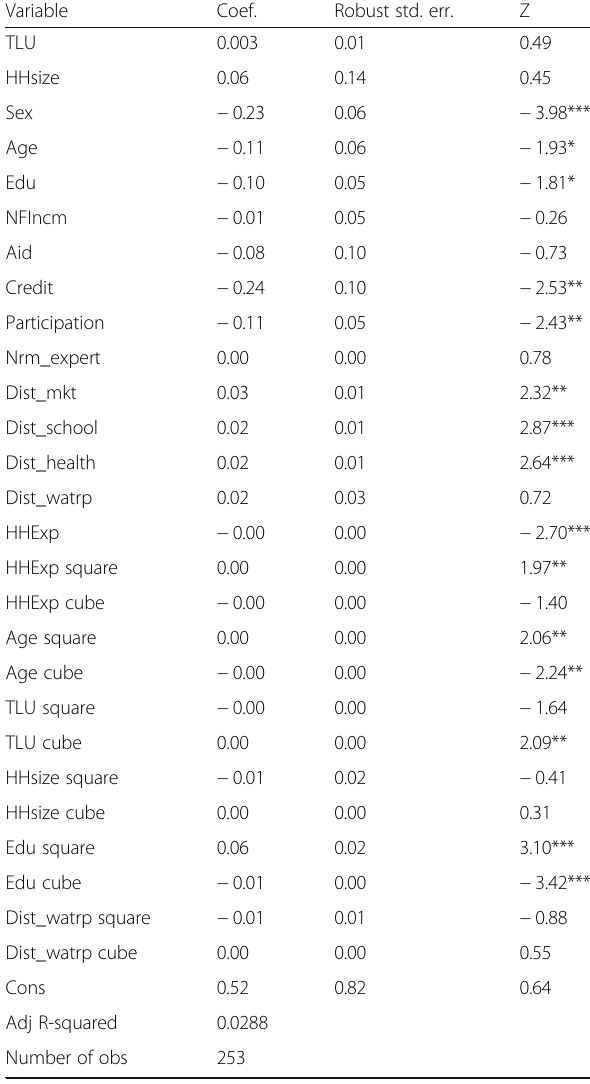
Table 5 Estimated GPS: linear regression of Prosopis invasion level on covariates Variable Coef. Robust std.